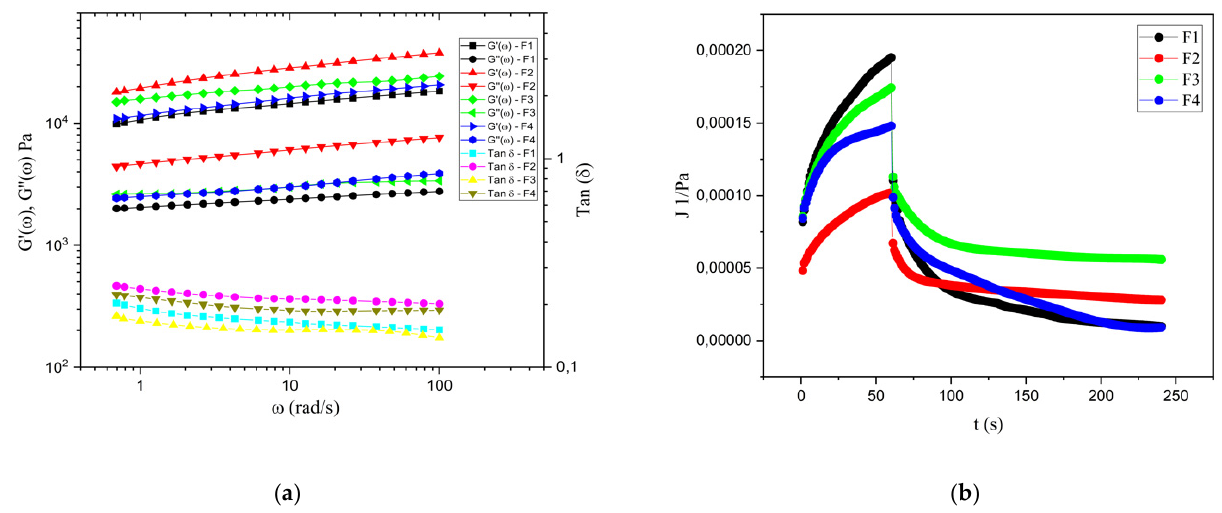
Figure 5. Viscoelastic properties of hydrocolloids films: ( a ) behavior of dynamic module (G (cid:48) ,G (cid:48)(cid:48) ) and tangent of the phase angle (Tan δ ) in relation to frequency; ( b ) creep and recovery curves of hydrocolloid